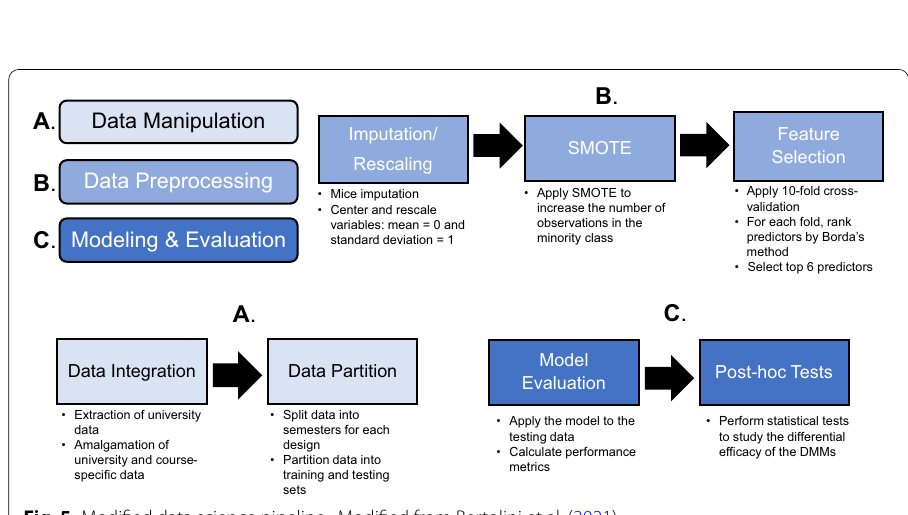
Fig. 5 Modified data science pipeline. Modified from Bertolini et al.